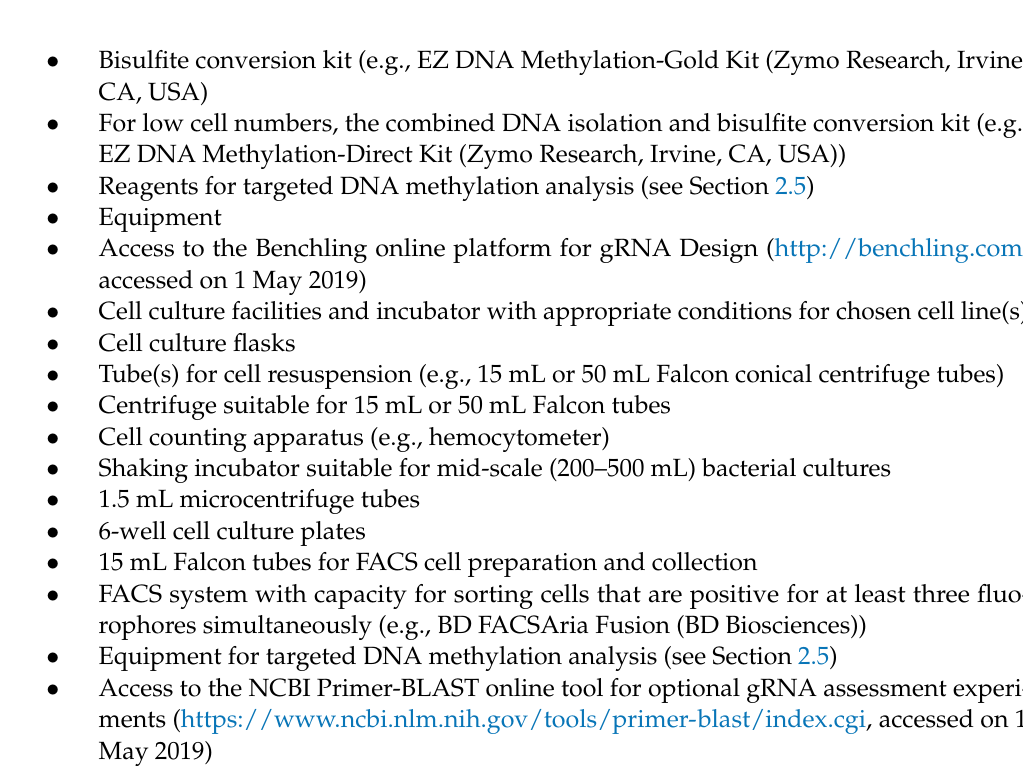
Table A1. Forward and reverse oligonucleotide sequences for EBF3 promoter gRNAs. Location Target Strand Forward/Reverse Sequence a